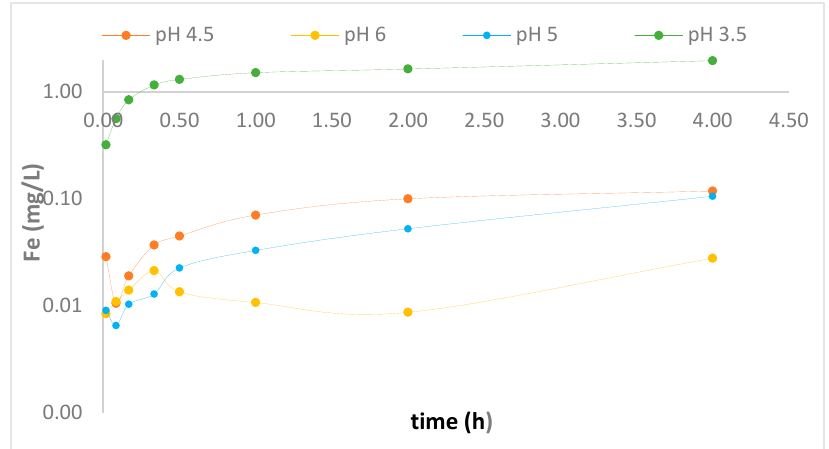
Figure 4. Release of dissolved iron ions -log Fe concentration (mg/L) during heterogeneous Fenton reaction of CE-nZVI/H 2 O 2 .